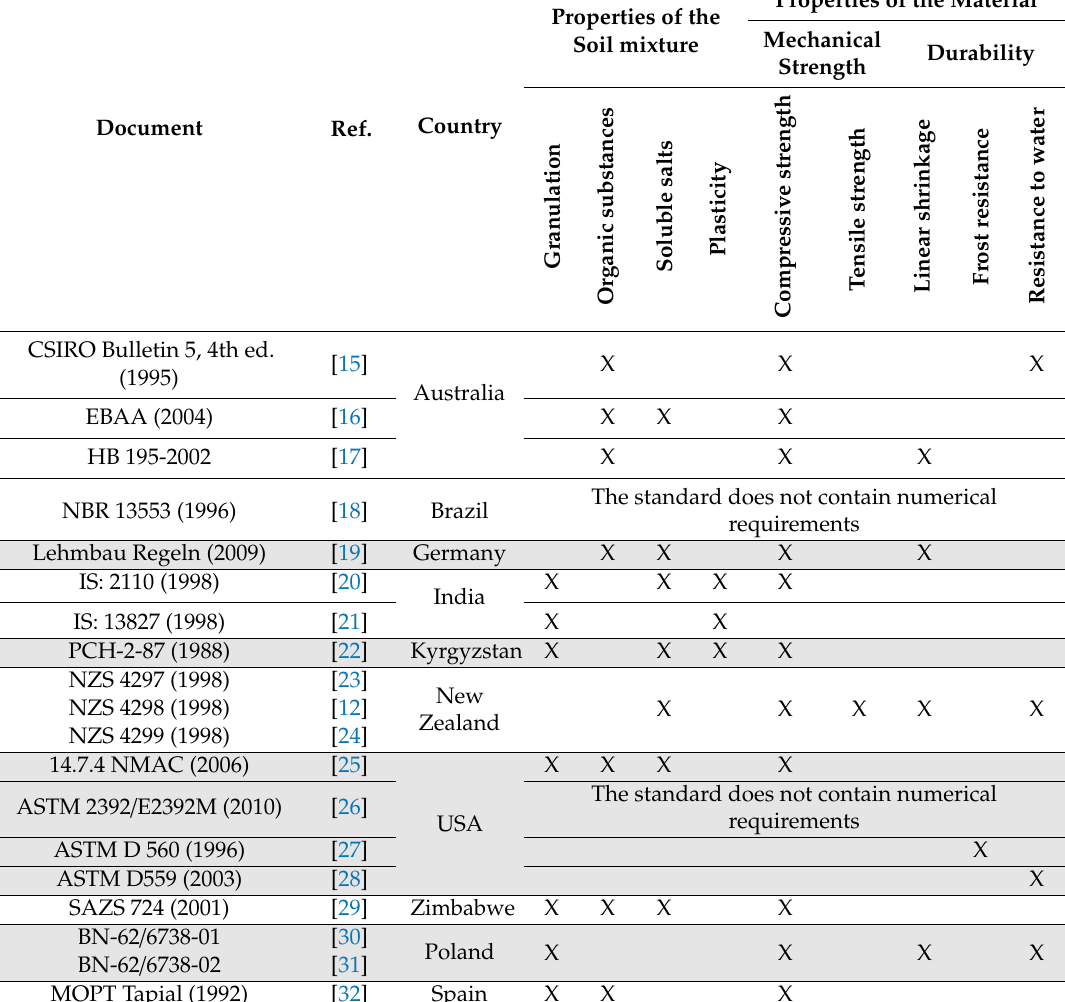
Table 1. Characteristics of rammed earth included in the standards. Grey colour indicates standards from countries with a humid continental